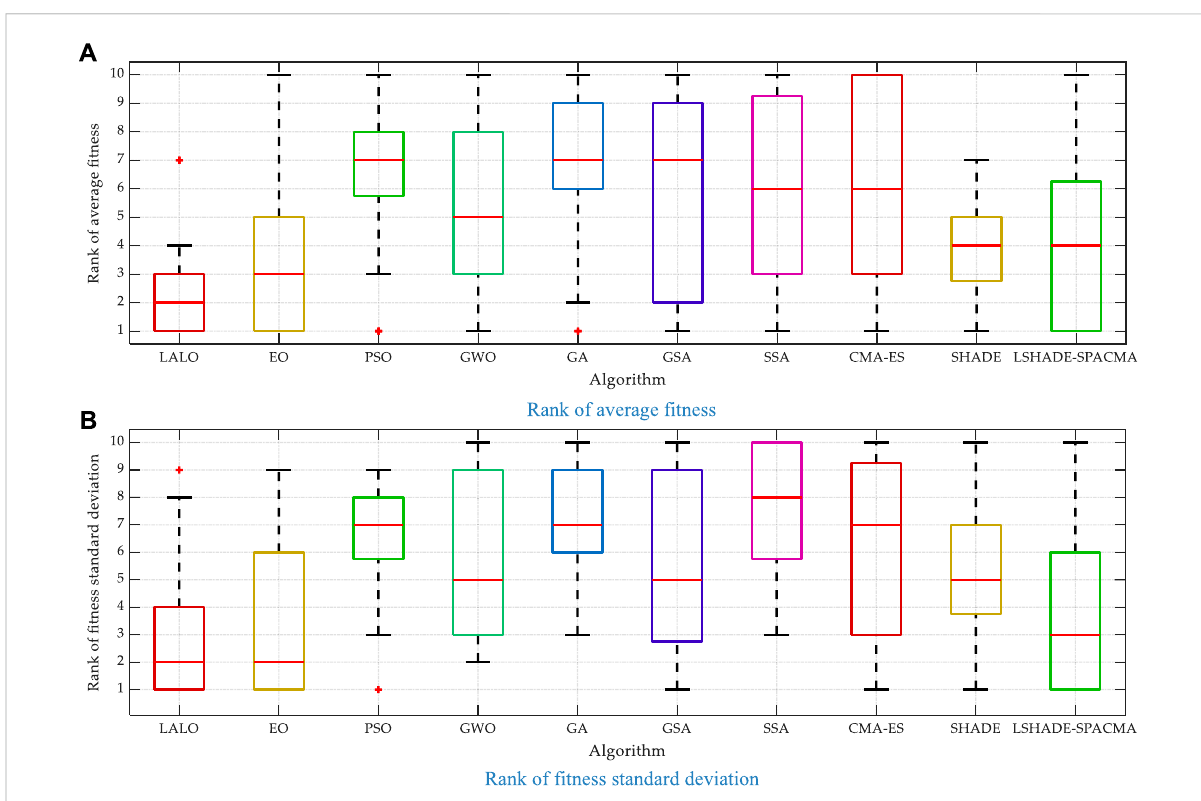
FIGURE 5 Box-and-whiskerplotsofranks obtained bydifferentalgorithmsfor thebenchmarkfunctionsfrom F 1 to F 7 . (A) Rankofaverage fi tness. (B) Rank of fi tness standard deviation.